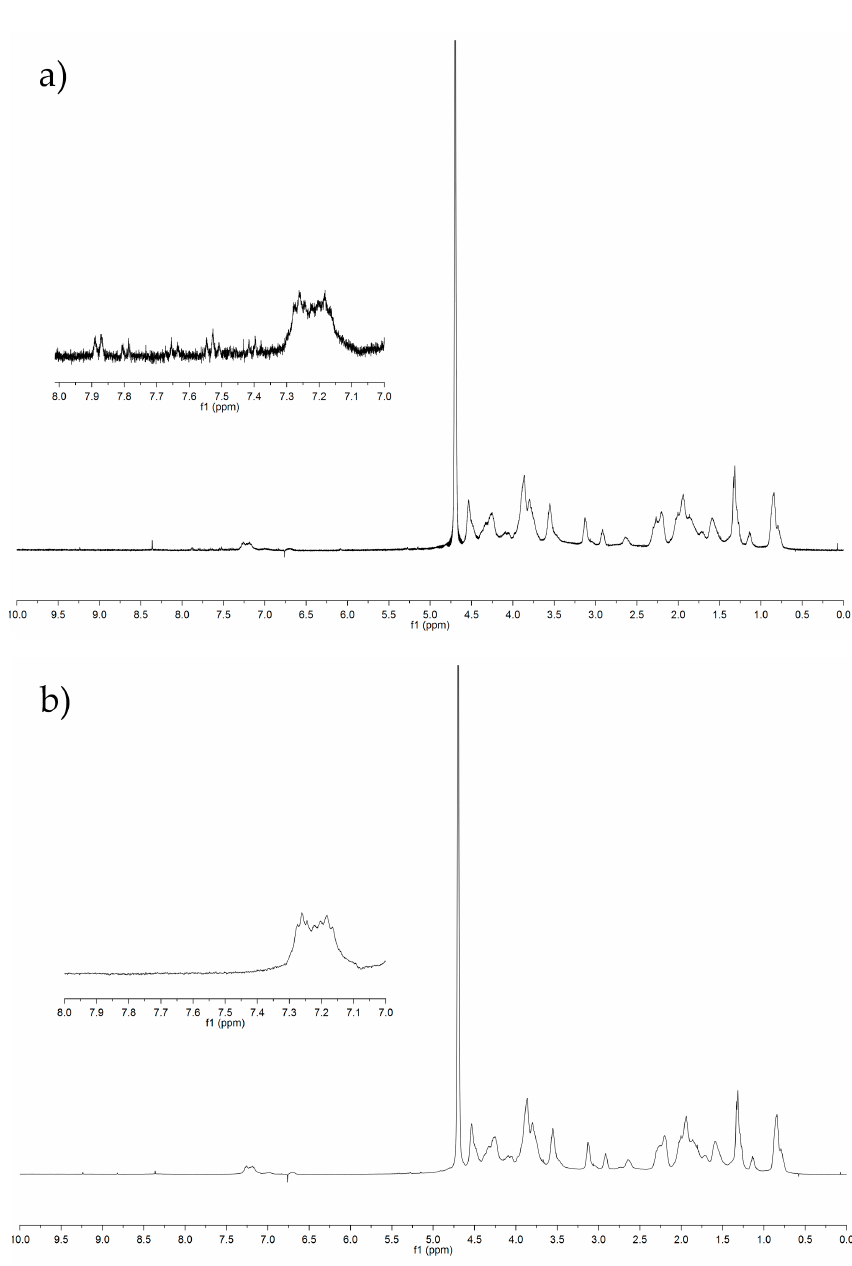
µ mol ( a ) compared to untreated